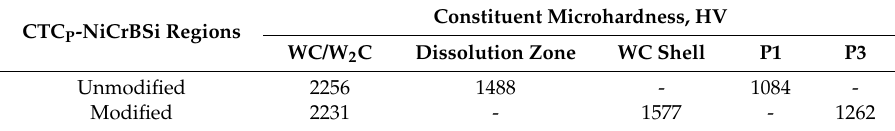
Table 2. Microhardness of the microstructure constituent in CTC P -NiCrBSi.